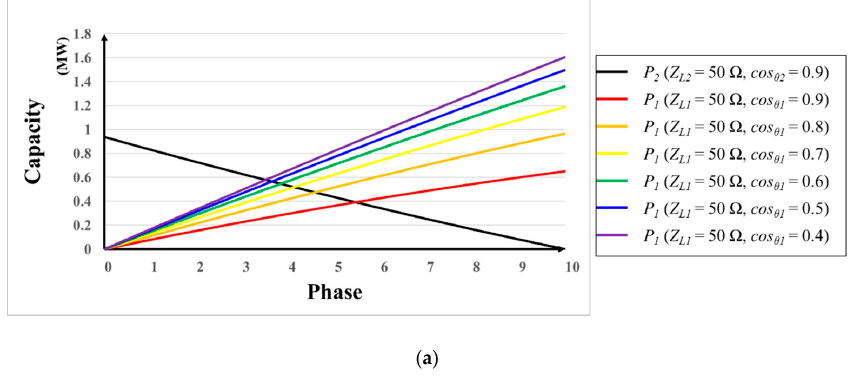
Table 1. APC (active phase controller) capacity according to load impedance change when the power factor is